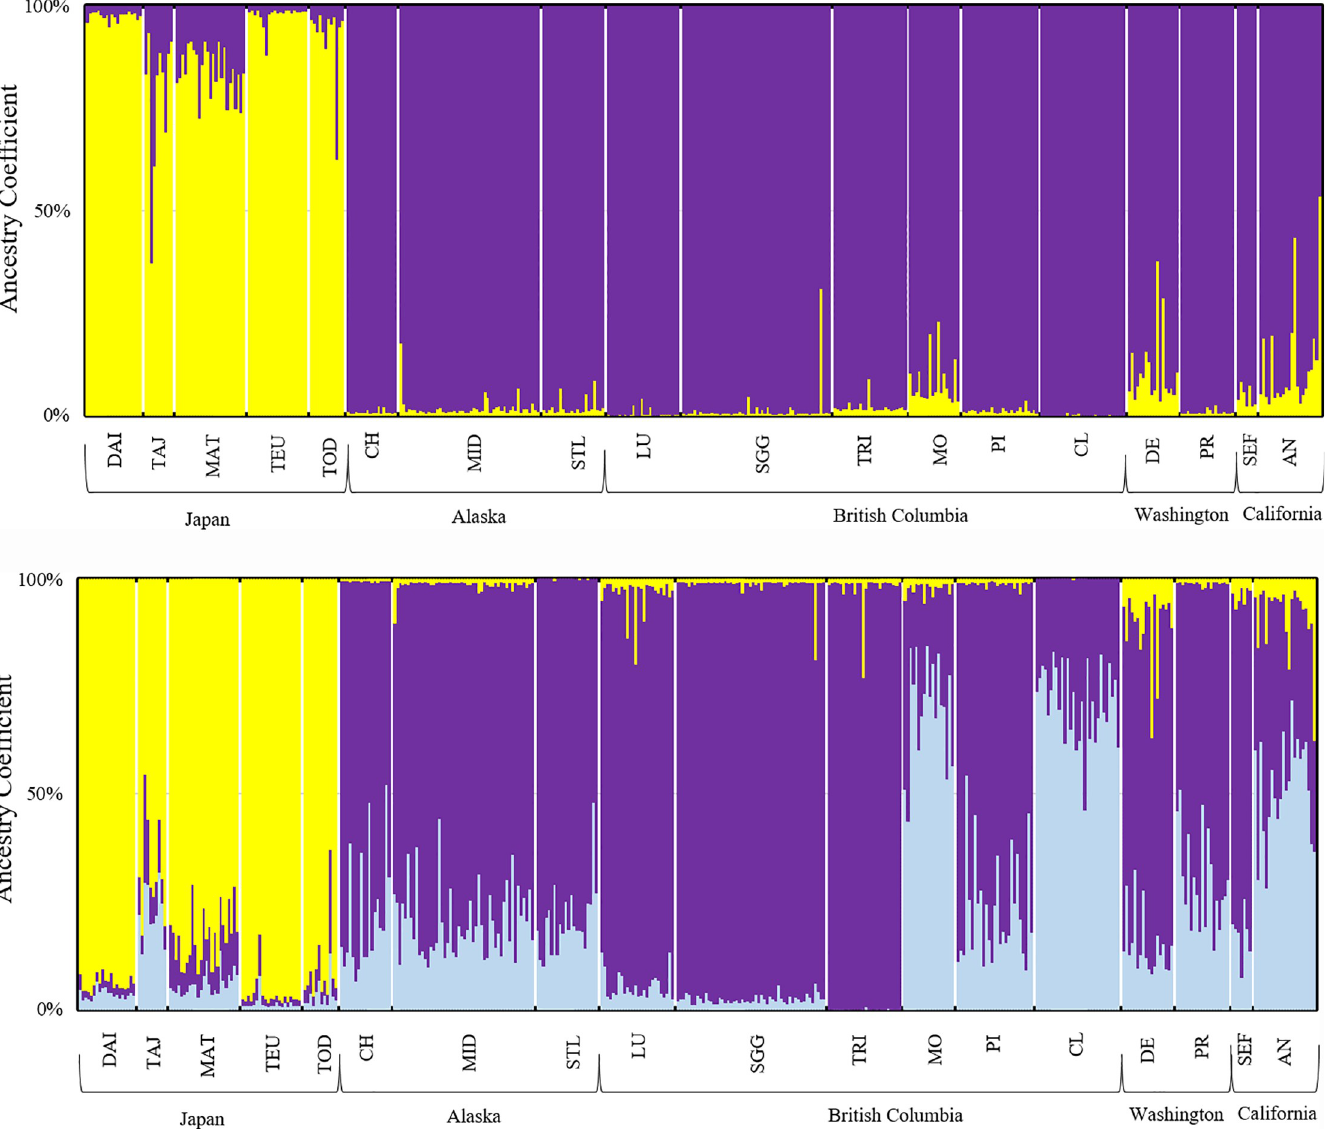
Fig 2. Genetic groups for 18 North Pacific Ocean rhinoceros auklet colonies for ten microsatellite loci as inferred by STRUCTURE v2.3. Histogram plot shows ancestry coefficient (Q) on the y-axis with individuals plotted on the x-axis. Breeding populations are listed from the western North Pacific (left) to eastern North Pacific (right). Genetic clusters at a) K = 2 and b) K = 3. (a) At K = 2 two genetic clusters occur between the western Pacific (Q > 70% yellow; Daikoku (DAI), Tajima (TAJ), Matsumae (MAT), Teuri (TEU), Todojima (TOD)) from the eastern Pacific (Q > 80% purple; Chowiet (CH), Middleton (MID), St. Lazaria (STL), Lucy (LU), S’Gang Gwaay (SGG), Triangle (TRI), Moore (MO), Pine (PI), Cleland (CL), Destruction (DE), Protection (PR), Southeast Farallon (SEF), A ñ o Nuevo (AN)). (b) At K = 3 one cluster occurs for the western Pacific (Q > 70% yellow). For the eastern Pacific there are two clusters: Q > 60% for Chowiet, Middleton, St. Lazaria, Lucy, S’Gang Gwaay, Triangle, Pine, Destruction, Protection, Southeast Farallone (in purple); and Q > 60% for Moore and Cleland, with 60% of individuals from the A ñ o Nuevo colony showing Q > 50% for cluster two (in light blue).